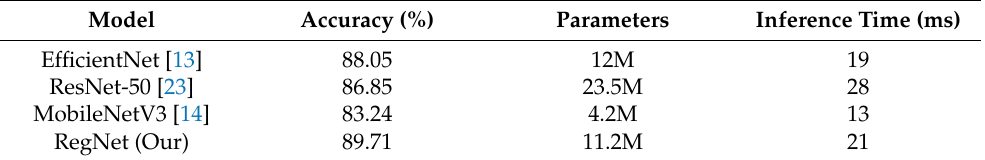
Figure 5. Training and validation accuracy/loss performance of the fine-tuned RegNet model on Fold 5. Table 3. Performance of the proposed manipulated face image identification model compared to the other models. The best performance for each metric is highlighted in bold.